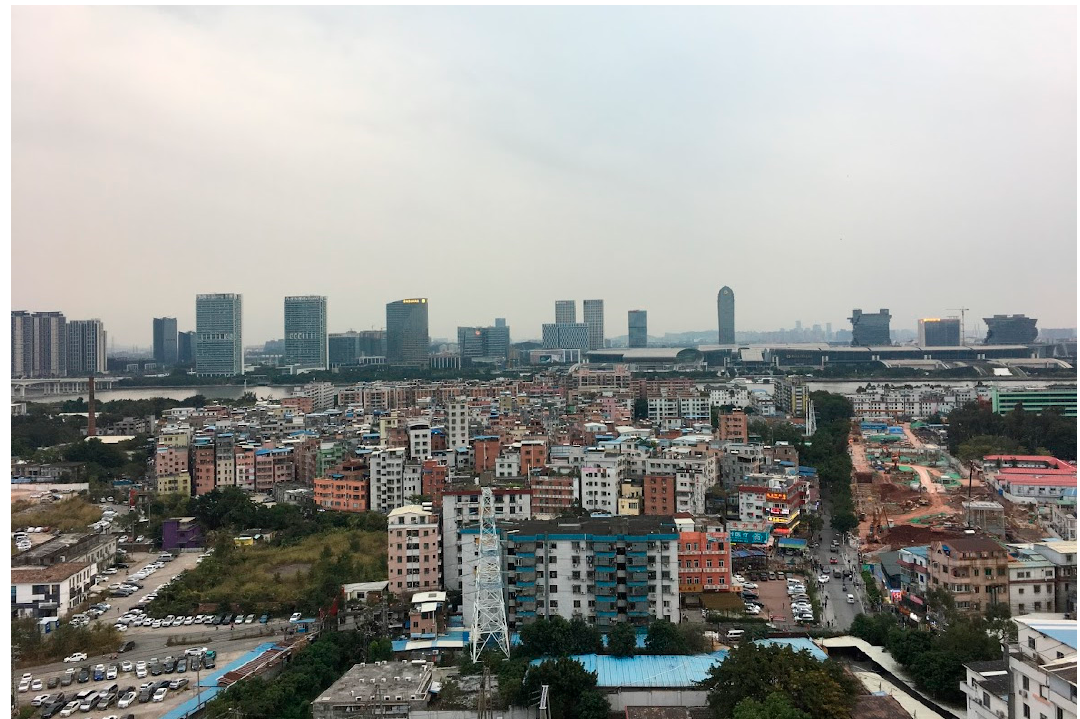
Figure 10. Informal settlements providing housing for the rural migrant population. Source: taken by the